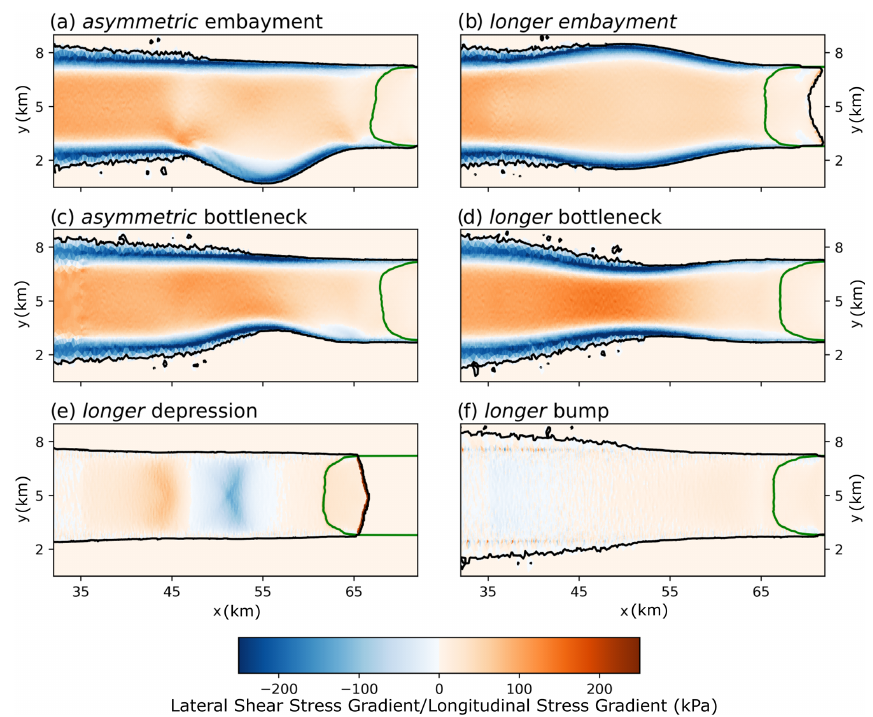
Figure A3. Stress fields in asymmetric and longer geometries. Lateral shear stress gradients for lateral perturbations (a, b, c, d) and longitu- dinal stress gradients for basal perturbations (e, f) .